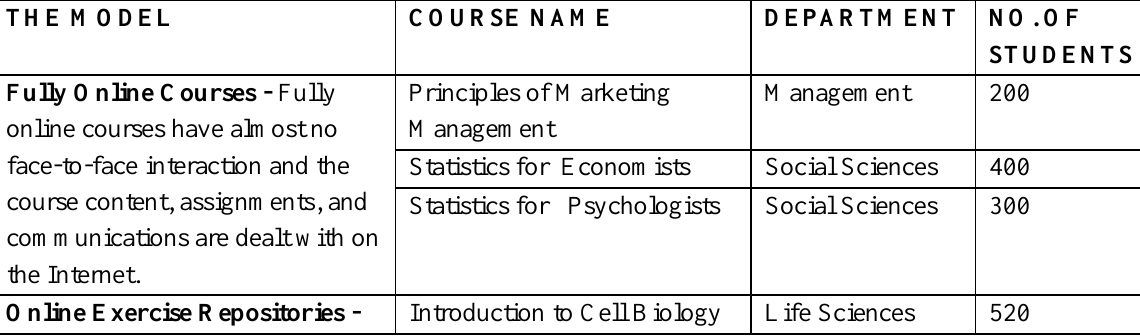
Case Studies of Campus-Wide, Web-Based, Innovative Pedagogical Practices THE